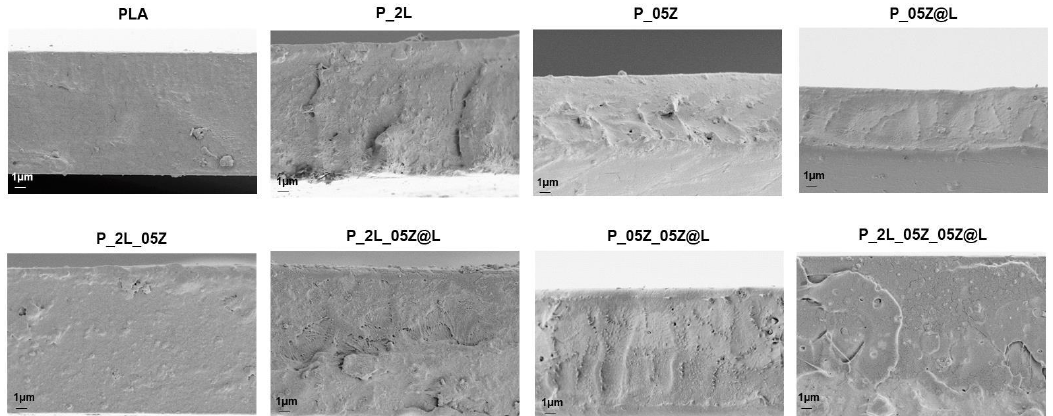
Figure 4. FESEM investigation of fractured surfaces for PLA based formulations.